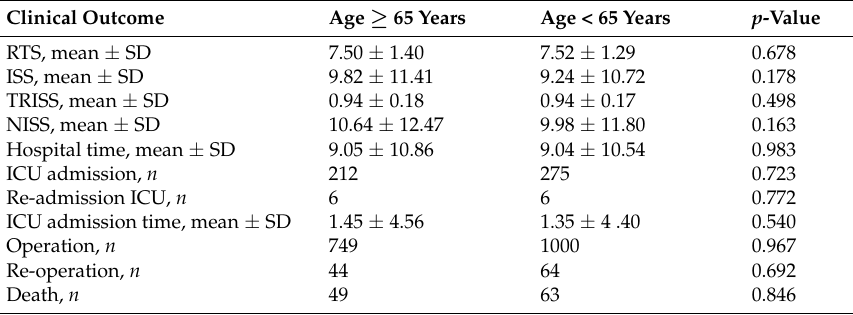
Table 4. Clinical outcome of younger and elderly patients.